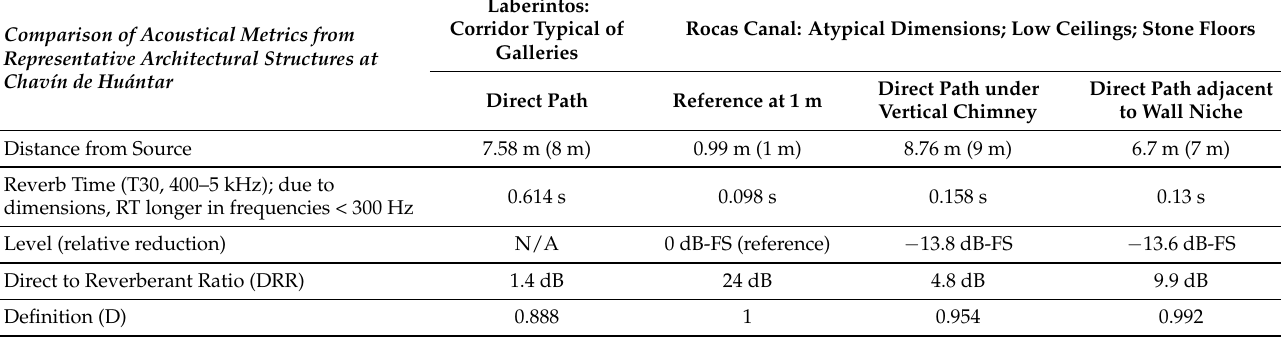
Table 3. Acoustical metrics from the interior architecture of Chavín de Huántar, Perú: calculated (using EASERA software) from a variety of direct-path impulse response (IR) measurements using the repeated exponential sinusoidal sweep method. Source reproduced using a Meyer MM-4XP directional single-driver loudspeaker (as a proxy for speech-signal directivity, for ecological validity); receivers were Countryman B6 omnidirectional microphones at an average human head-height.